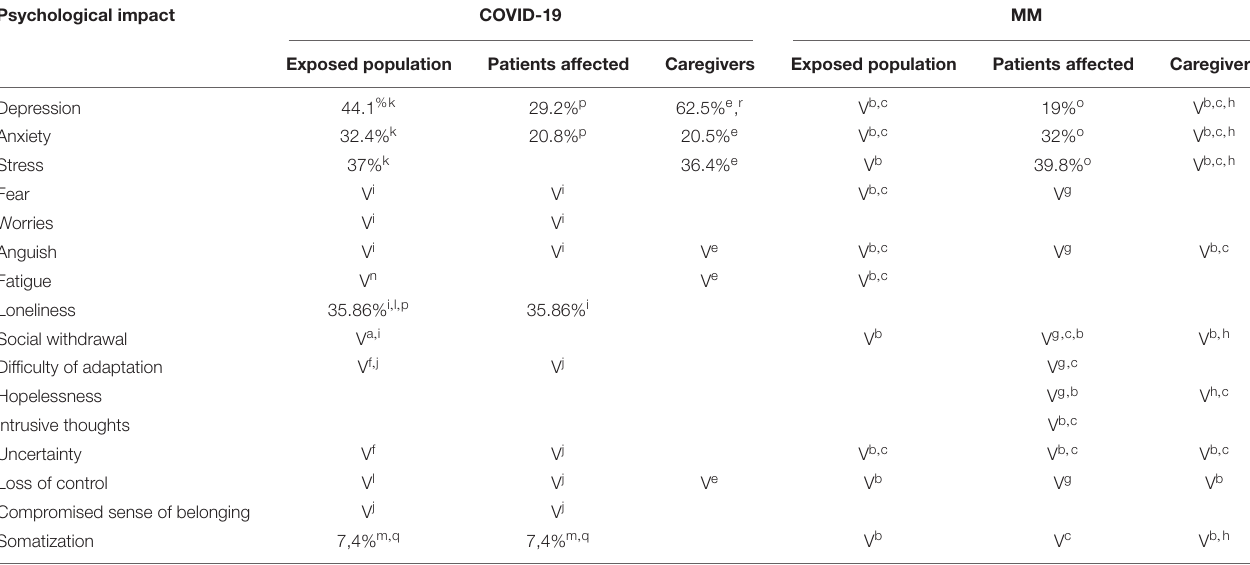
TABLE 2 | Psychological impact of COVID-19 and MM on exposed population, affected patients, and their caregivers. Psychological